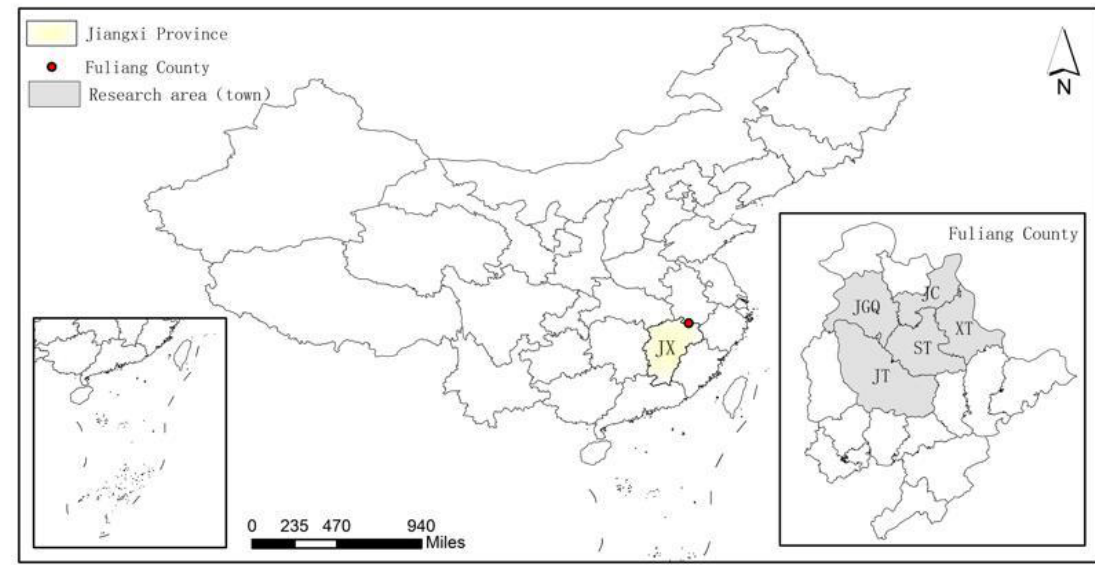
Figure 2. The geographical location of the study area.